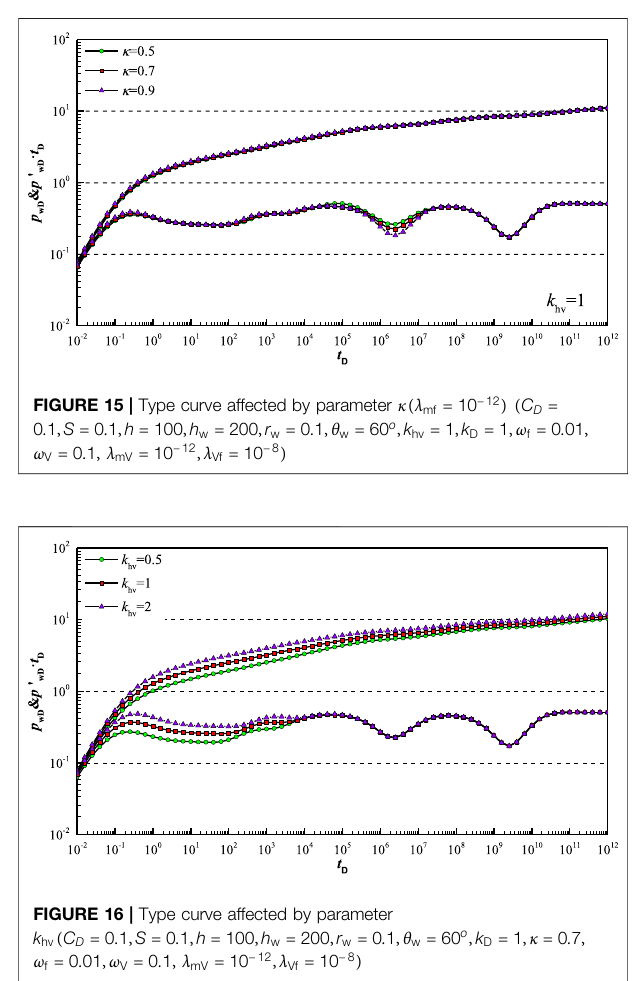
FIGURE 16 | Type curve affected by parameter k hv ( C D (cid:2) 0 . 1 , S (cid:2) 0 . 1 , h (cid:2) 100 , h w (cid:2) 200 , r w (cid:2) 0 . 1 , θ w (cid:2) 60 o , k D (cid:2) 1 , κ (cid:2) 0 . 7 , ω (cid:2) 0 . 01 , ω (cid:2) 0 . 1 , λ (cid:2) 10 − 12 , λ (cid:2) 10 − 8 f V mV Vf